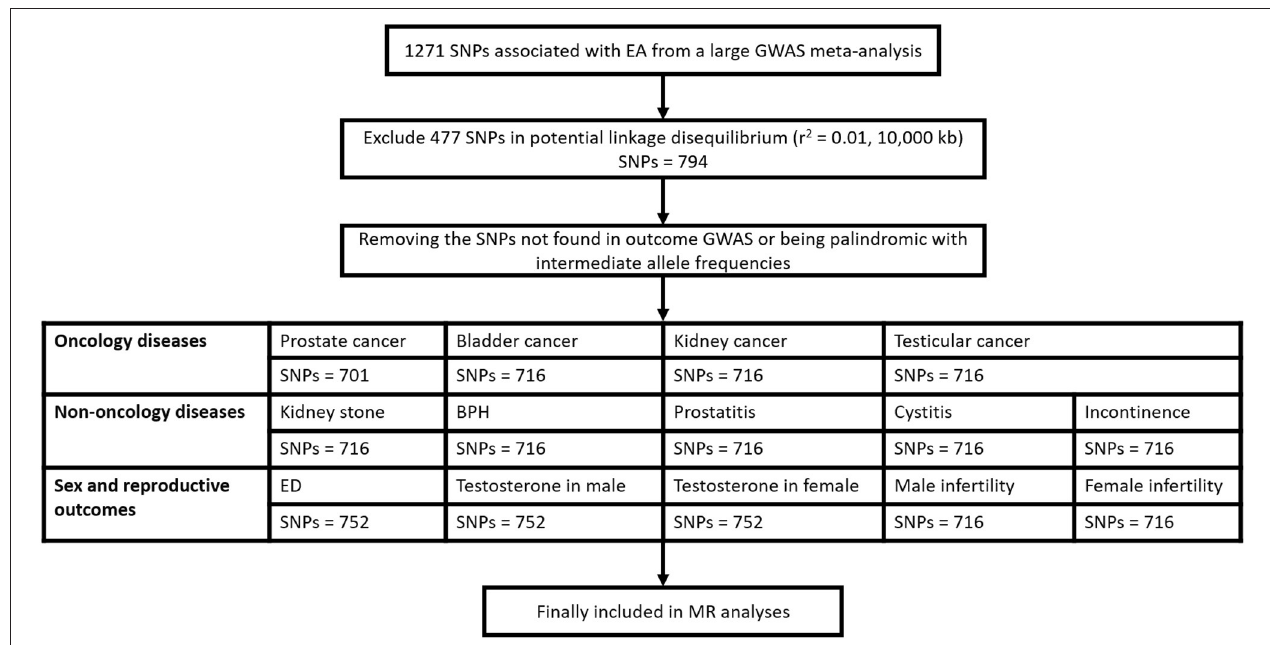
FIGURE 1 | Flow diagram for eligible SNPs selection for each of the 14 outcomes. SNP, single nucleotide polymorphism; EA, educational attainment; GWAS, genome wide association study; BPH, benign prostatic hyperplasia; ED, erectile dysfunction.